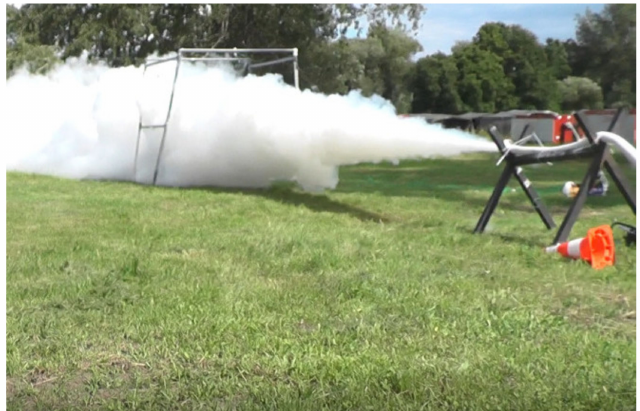
Figure 12. The shape of the LNG cloud during release against a frame with a mounted system of thermocouples.